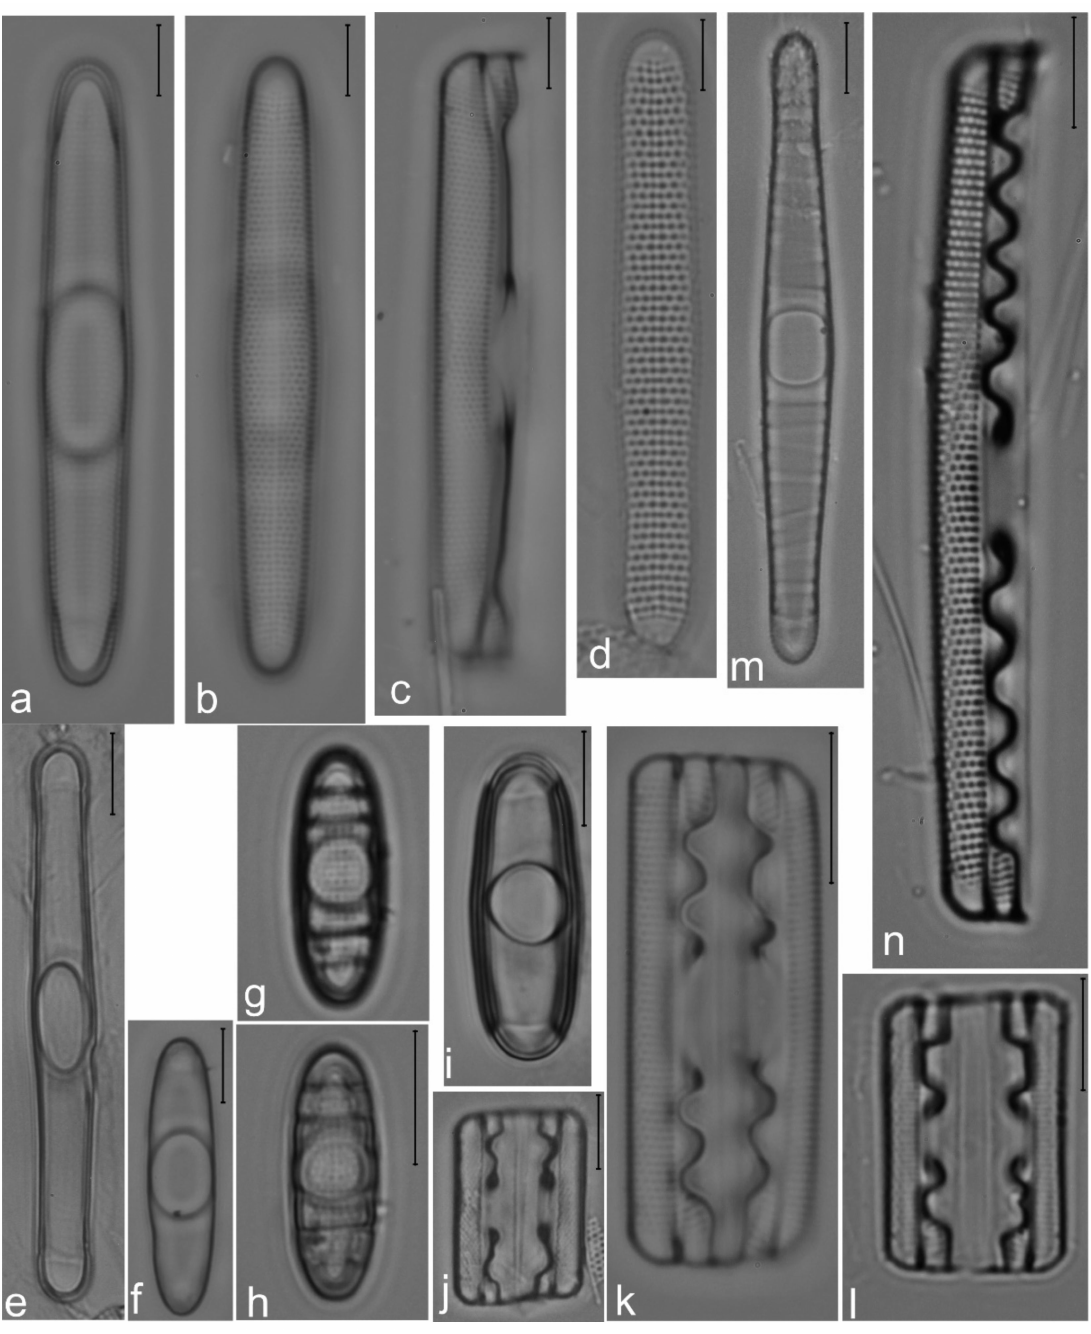
Figure 12. ( a – c ) Grammatophora oceanica var. oceanica ; ( d , k , m , n ) G . serpentina ; ( e ) G . oceanica var. subtilissima ; ( f , j , l ) G . marina ; ( g – i ) G . hamulifera . Scale bar = 10 µ